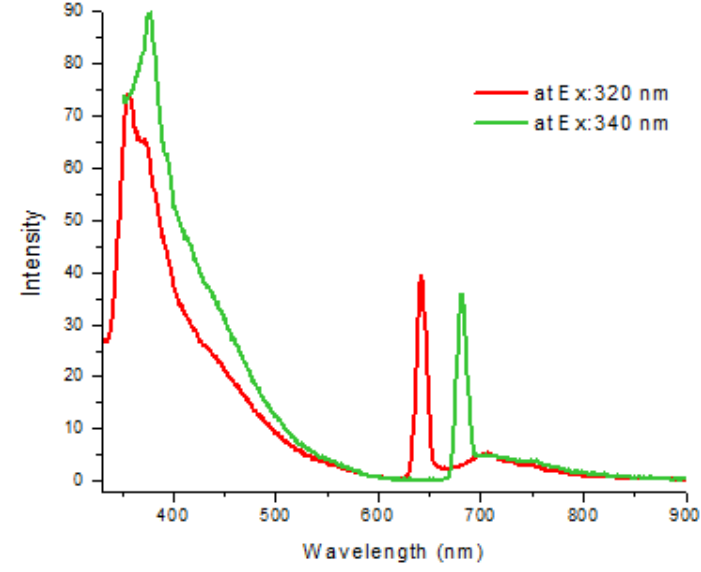
Figure S17: Emission spectra of dialdehyde o -HON at different excitation wavelengths